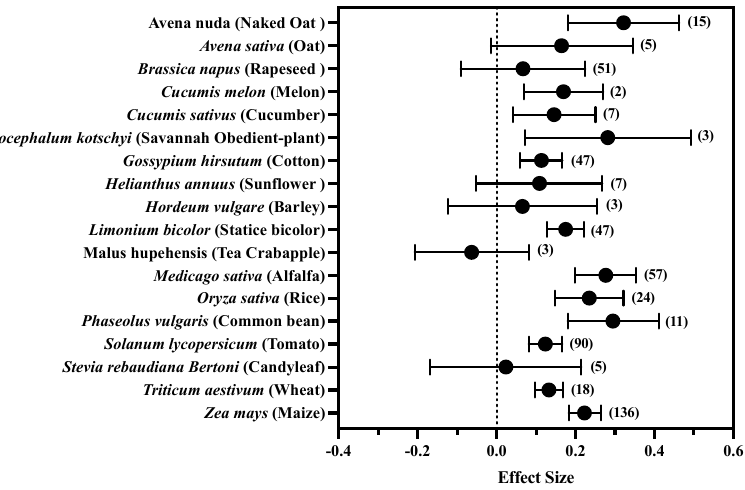
Figure 4. Effect of exogenous MT on plant growth under salt stress. The symbol represents the effect size, and the bars show the 95% bootstrapped confidence intervals. The values in the parentheses show the number of